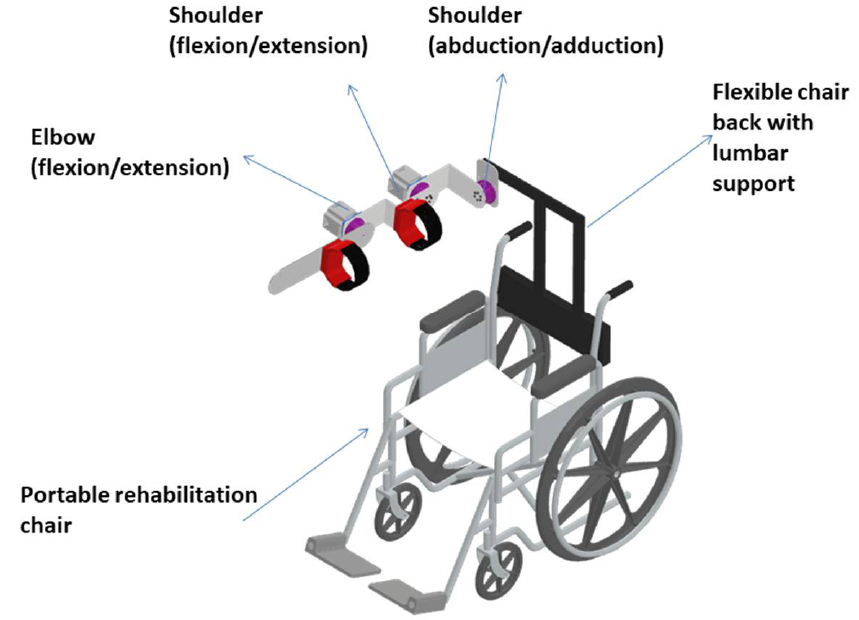
Figure 4. SAMA exoskeleton CAD model.